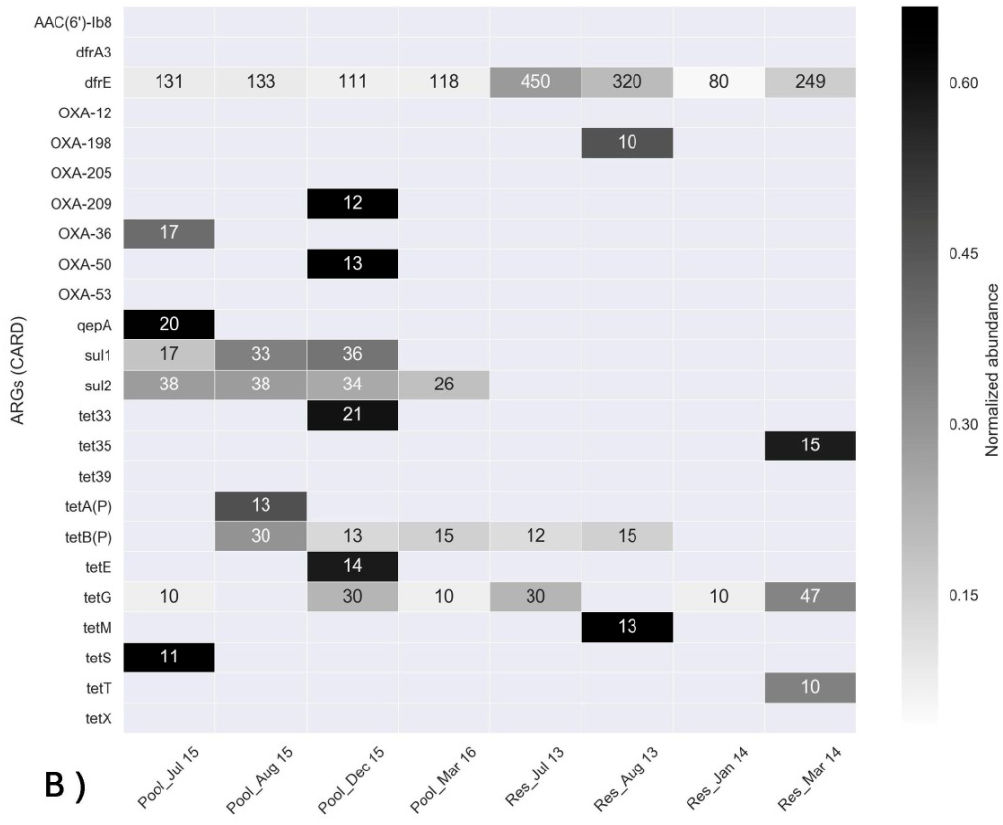
Figure 5. Heat maps showing the relative abundance of predominant ARGs in FP-03 (Pool) and the Res (Res) based on shotgun metagenomic data analyzed with the highly curated COSMOSID ( A ) and CARD ( B ) bioinformatic pipelines, respectively. Numbers indicate the absolute abundance of the targeted genes in the individual samples. Only ARGs potentially associated with mobile genetic elements were included.